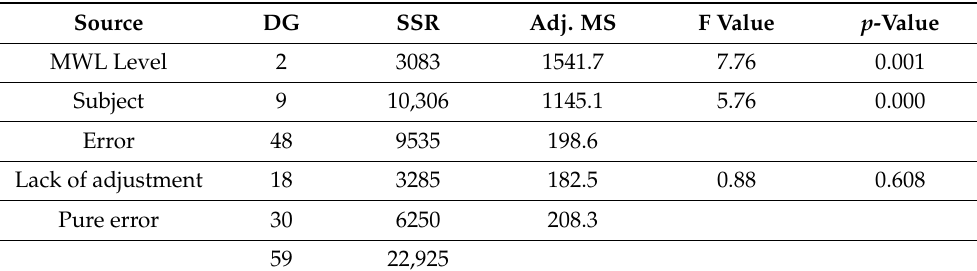
Table 5. Mental Workload Statistical Analysis